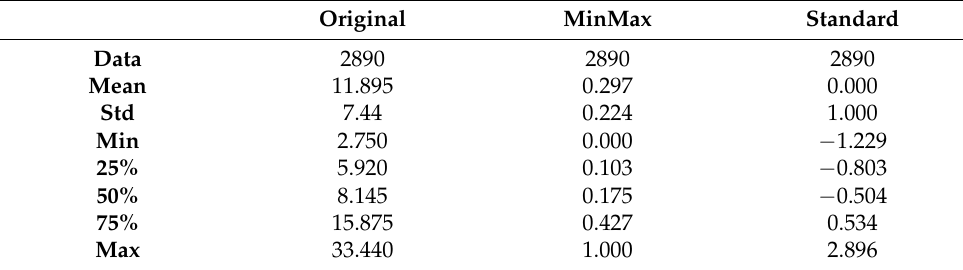
Table 1. Statistics of the original dataset.